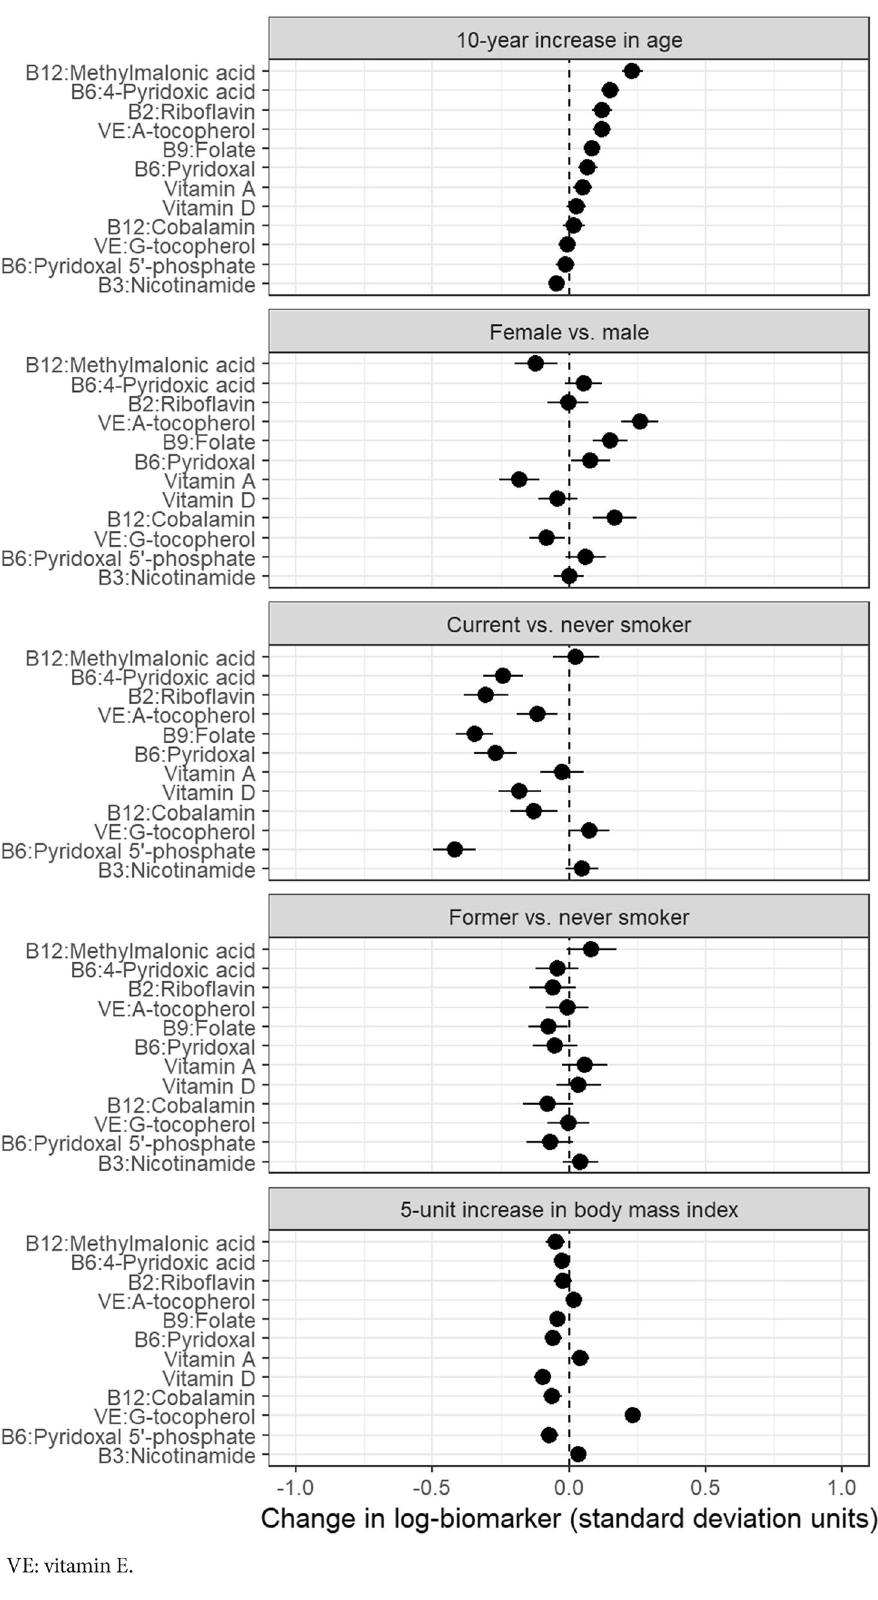
Figure 2. Differences in biomarkers of vitamin status by age, sex, smoking status, and BMI, in units of log-biomarker standard deviations, among 5167 control subjects in the Lung Cancer Cohort Consortium. Biomarkers are listed in order of the age